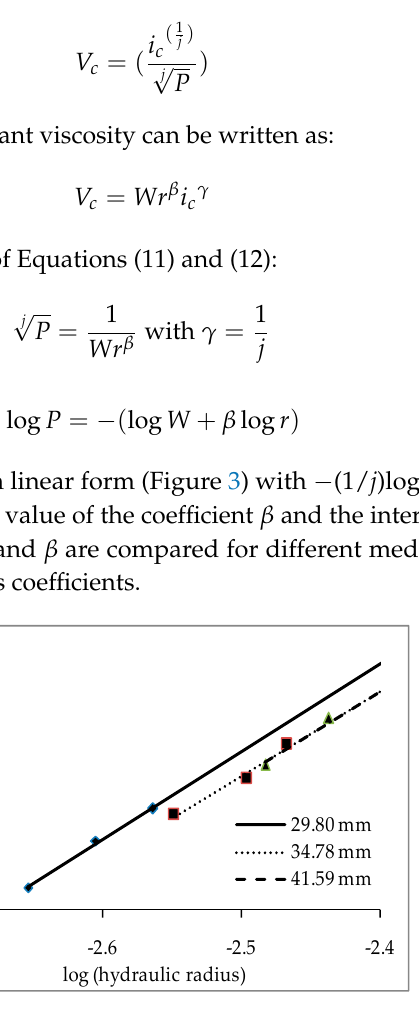
Figure 3. Equation (14) plotted in a linear form to find out the values of W and β .